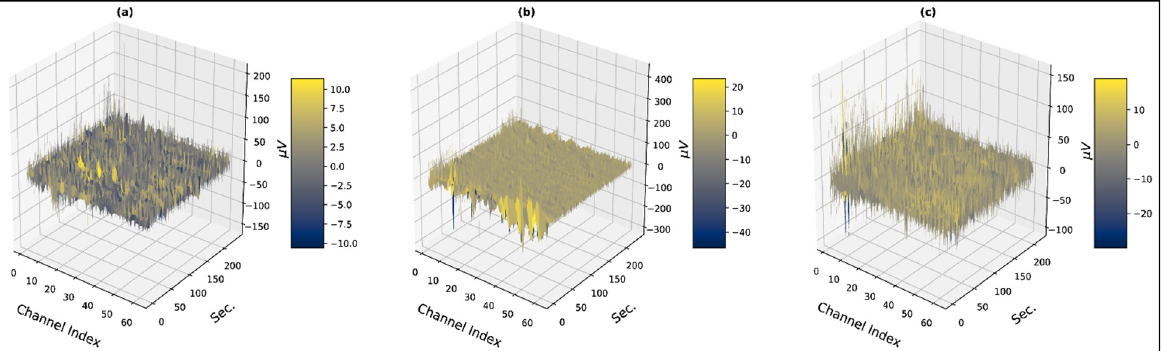
Figure 1. Three-dimensional visualization of faultless trials ( a ) subject: 4, state: negative, trial: 3 ( b )